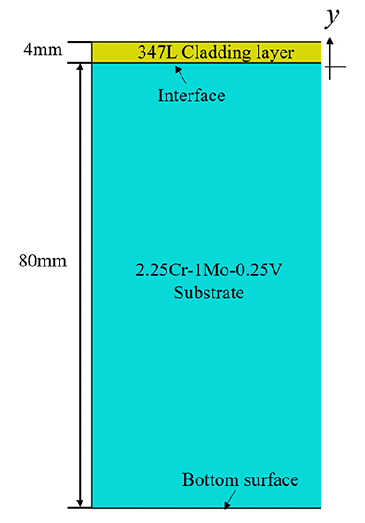
Figure 4. Geometric finite-element (FE) dimensions.